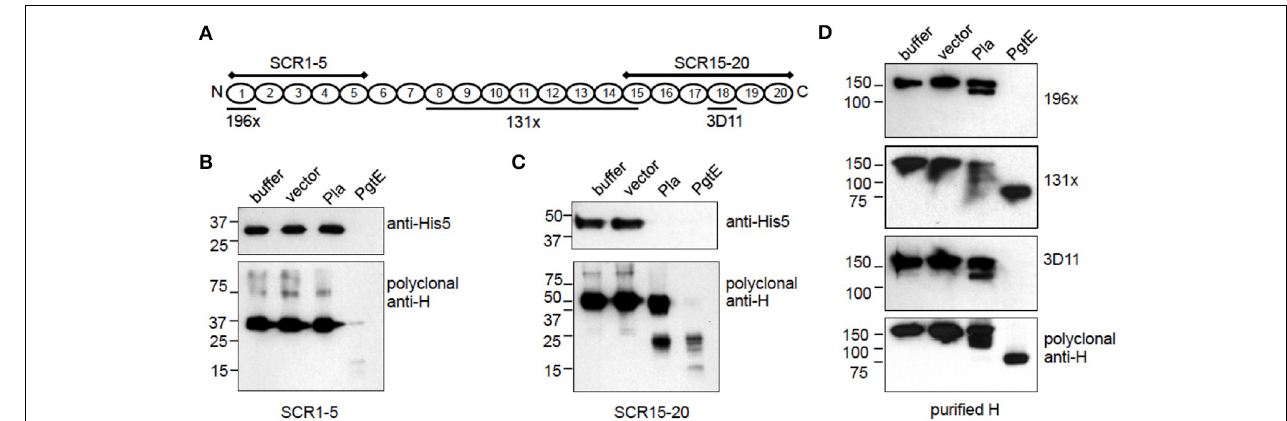
FIGURE 4 | Mapping of cleavage sites in factor H. (A) Graphic of factor H indicating the areas covered by the recombinant fragments SCR1-5 and SCR15-20 and the localization of the 196X, 131X, and 3D11mAb epitopes. (B–D) E. coli 83972 (cid:2) ompT bacteria expressing PgtE, Pla or the empty vector were incubated for 1h with equimolar amounts of recombinant H fragments SCR1-5, SCR15-20 or purified H. The non-reduced supernatants